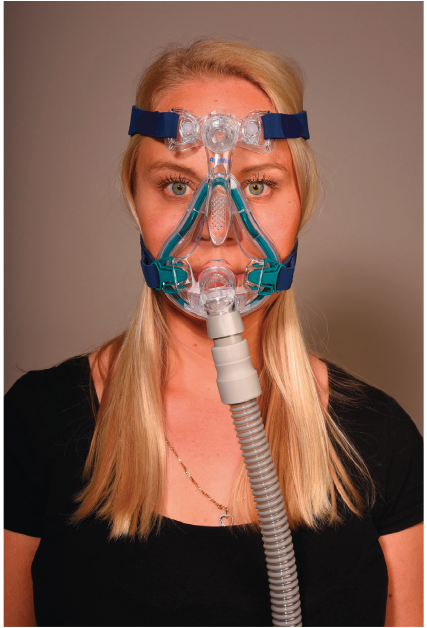
Figure 3: Oronasal